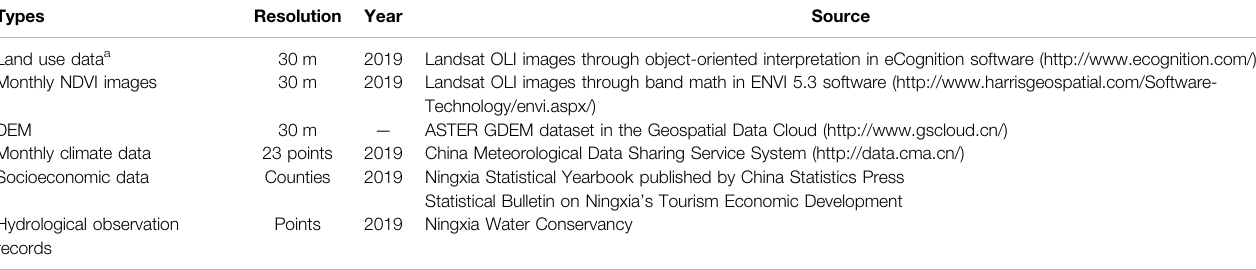
TABLE 1 | Sources of the primary